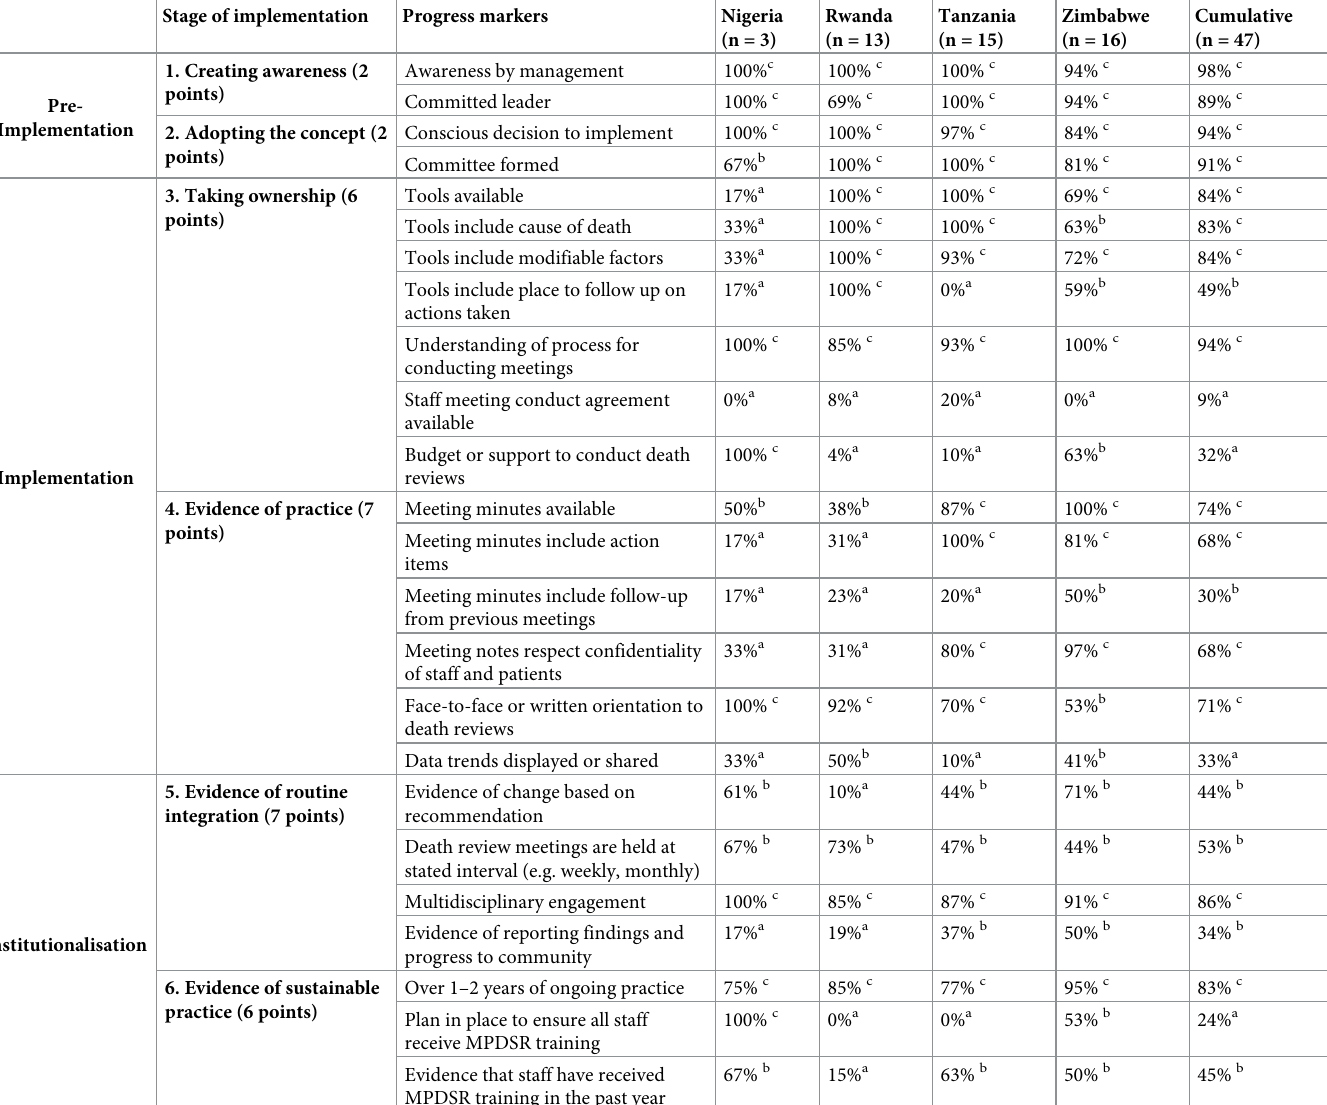
Table 4. Proportion of facilities meeting the progress markers for each stage of implementation (n = 47). Stage of